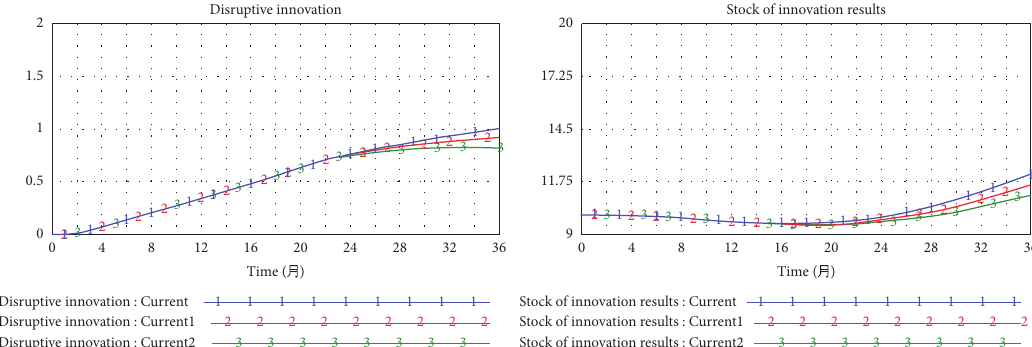
Figure 7: The impacts of architectural knowledge searching on disruptive innovation and stock of innovation